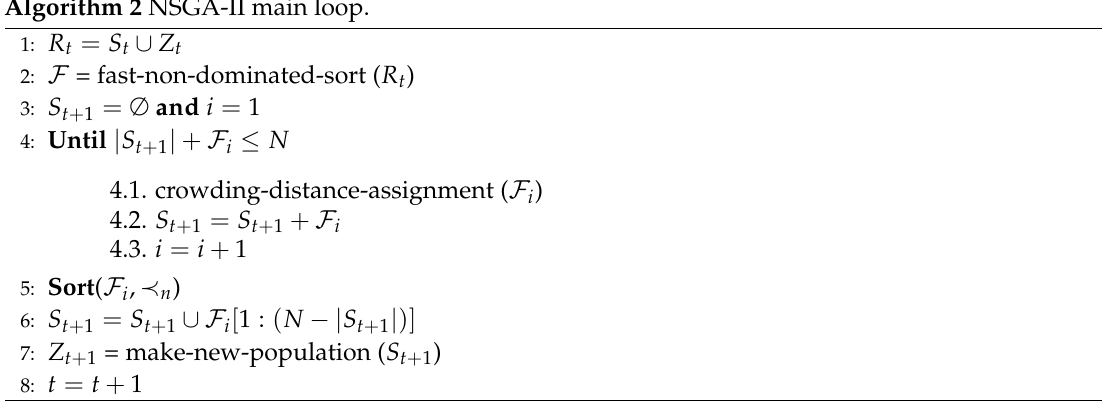
Algorithm 2 NSGA-II main